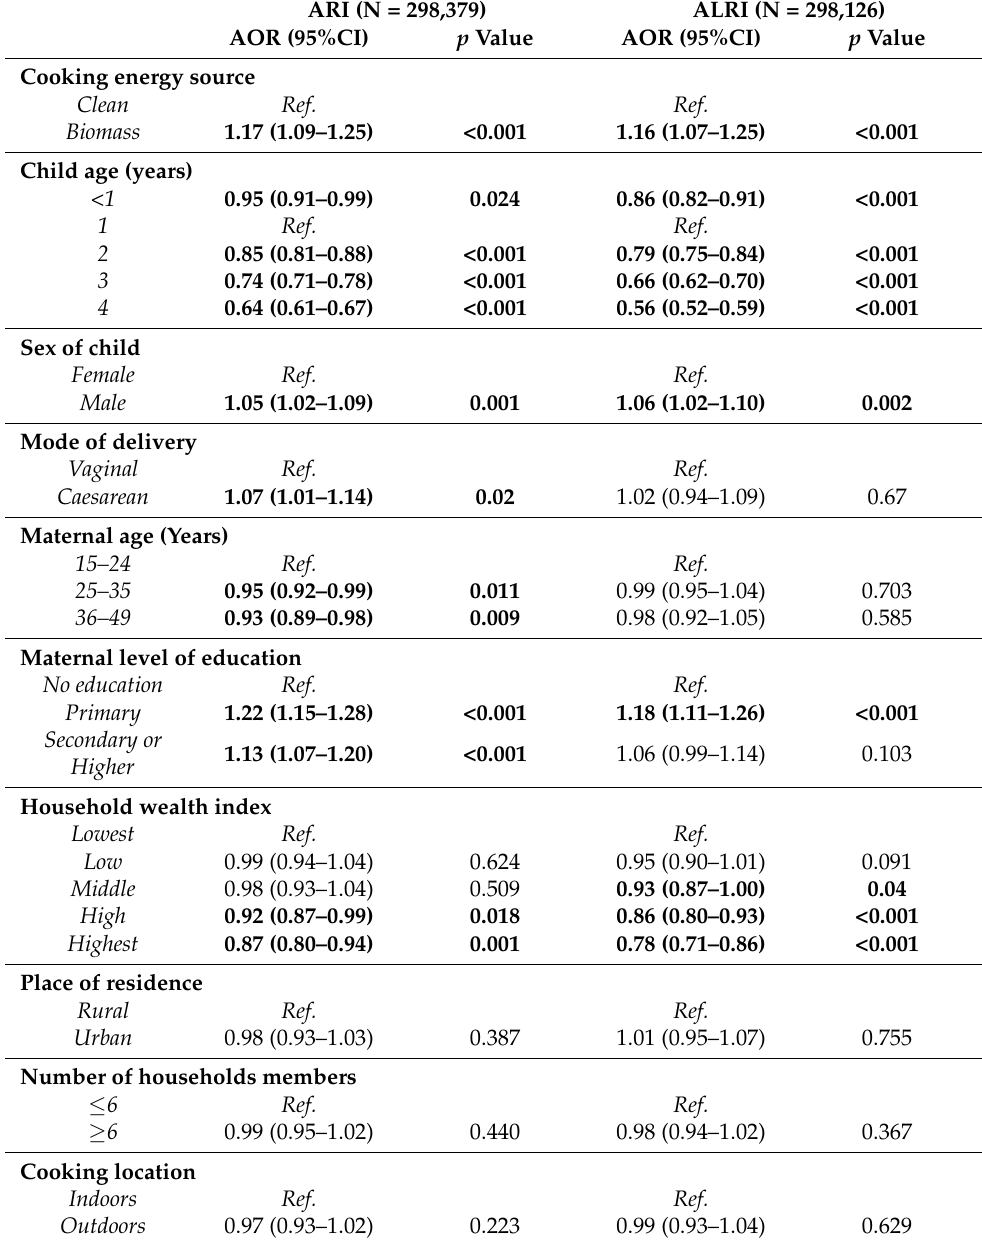
Table 2. Adjusted odds ratio (AOR) with 95% CI for the association of ARI and ALRI in children aged under five years with biomass cooking compared to cleaner cooking.